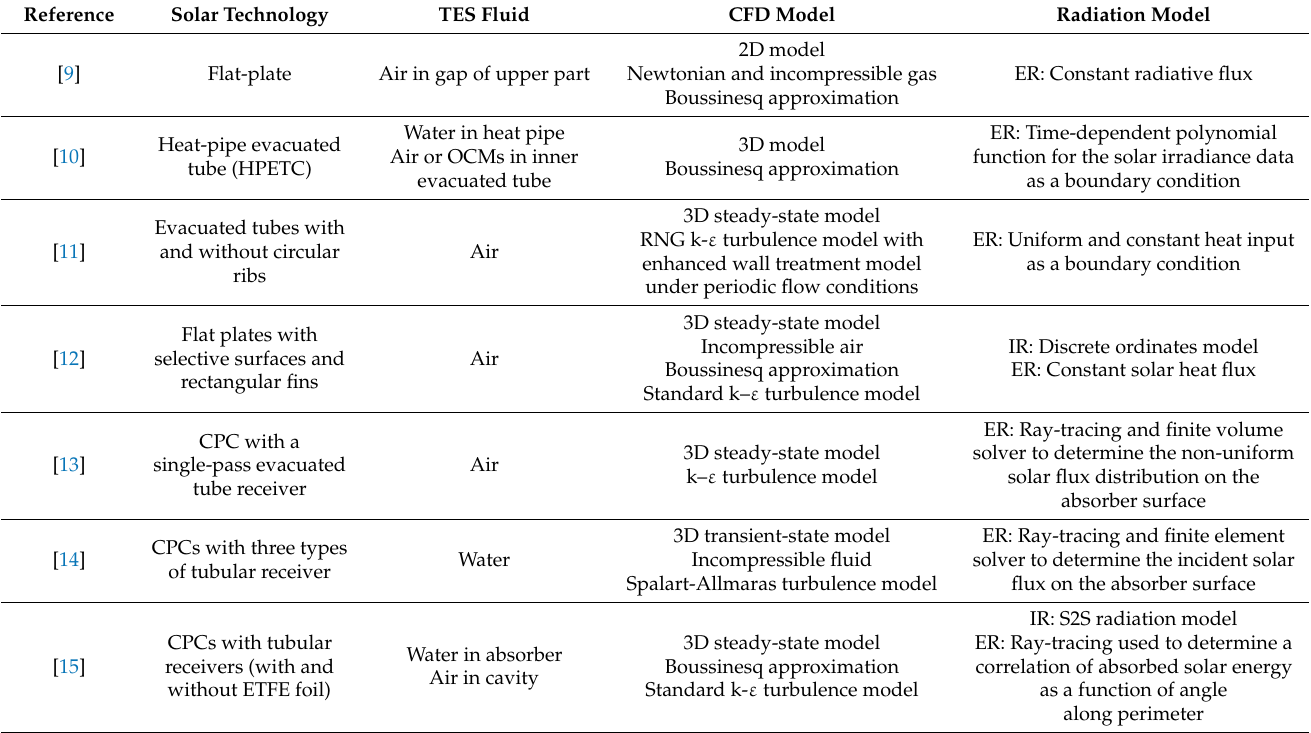
Table 1. Solar collectors CFD and radiation models in the literature